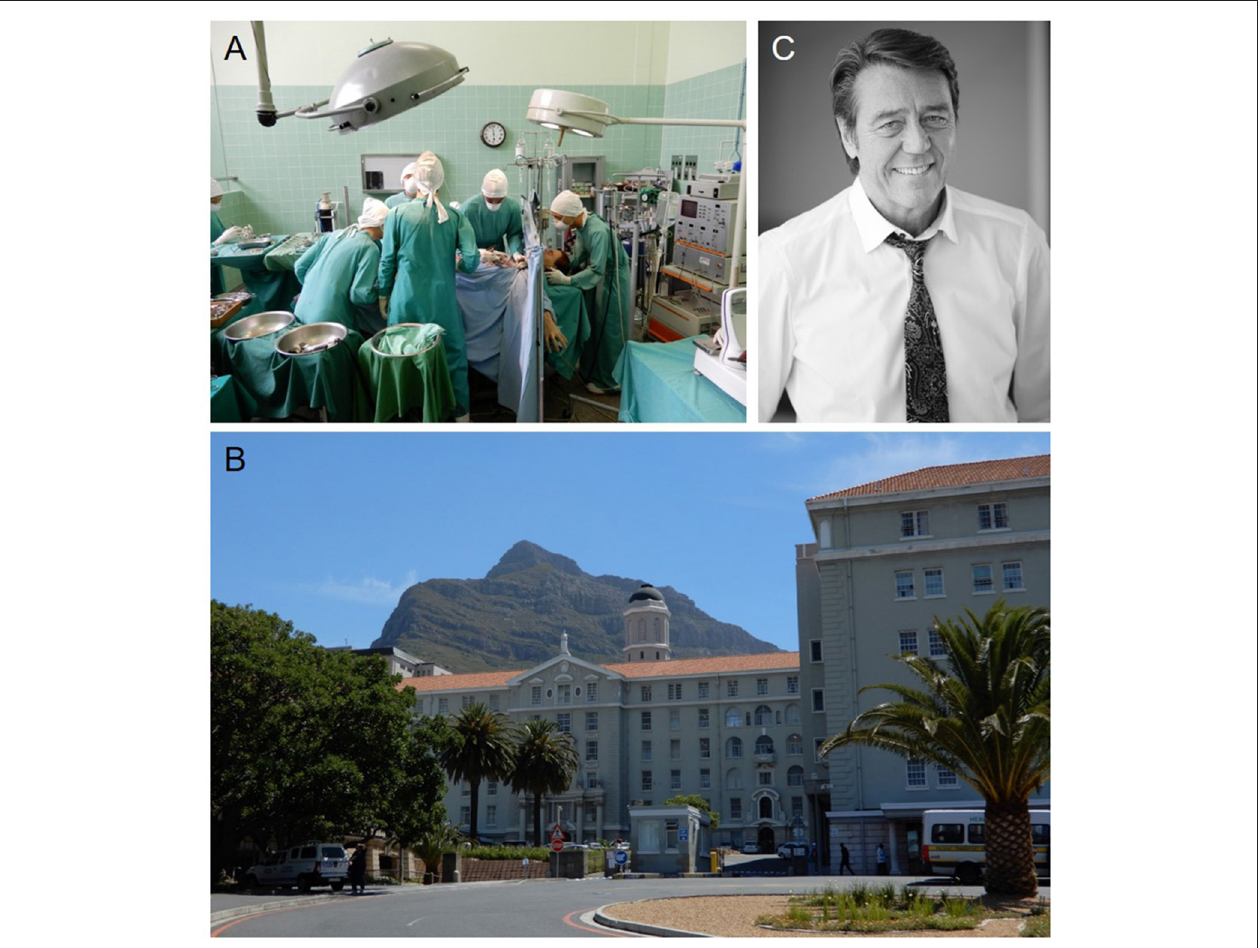
FIGURE 1 | (A) Wax figures of the cardiac surgeon Christiaan Barnard, his team, and the patient Louis Washkansky during the first human heart transplantation at the Heart of Cape Town Museum in Groote Schuur Hospital that took place in 1967. (B) Groote Schuur Hospital where the first human heart transplantation was performed by Christiaan Barnard. This beautiful hospital is located on the slope of Devil’s Peak shown in the background. (C) Peter Zella, MD, PD, Ph.D., FCs, Head of the Christiaan Barnard Department of Cardiothoracic Surgery at Groote Schuur Hospital of the University of Cape Town. He co-founded the ISACB and was a past president of the society. Dr. Zilla organized the 50th Anniversary Heart Transplant Celebration in Cape Town, “Courage and Innovation: 50 Years of transplantation” at Groote Schuur Hospital in December, 2017.